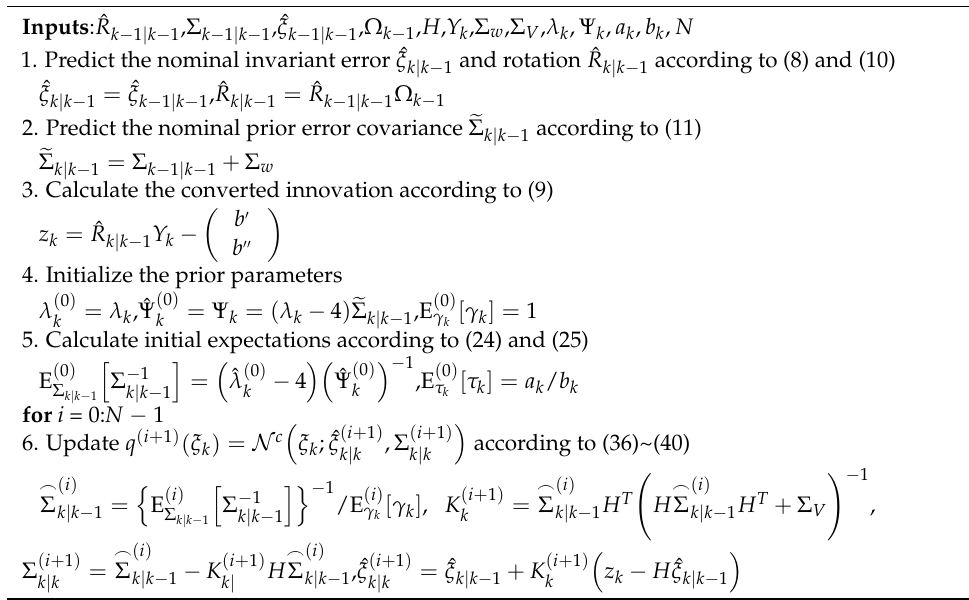
Algorithm 1. The filtering steps of one time instant in the proposed approach for attitude